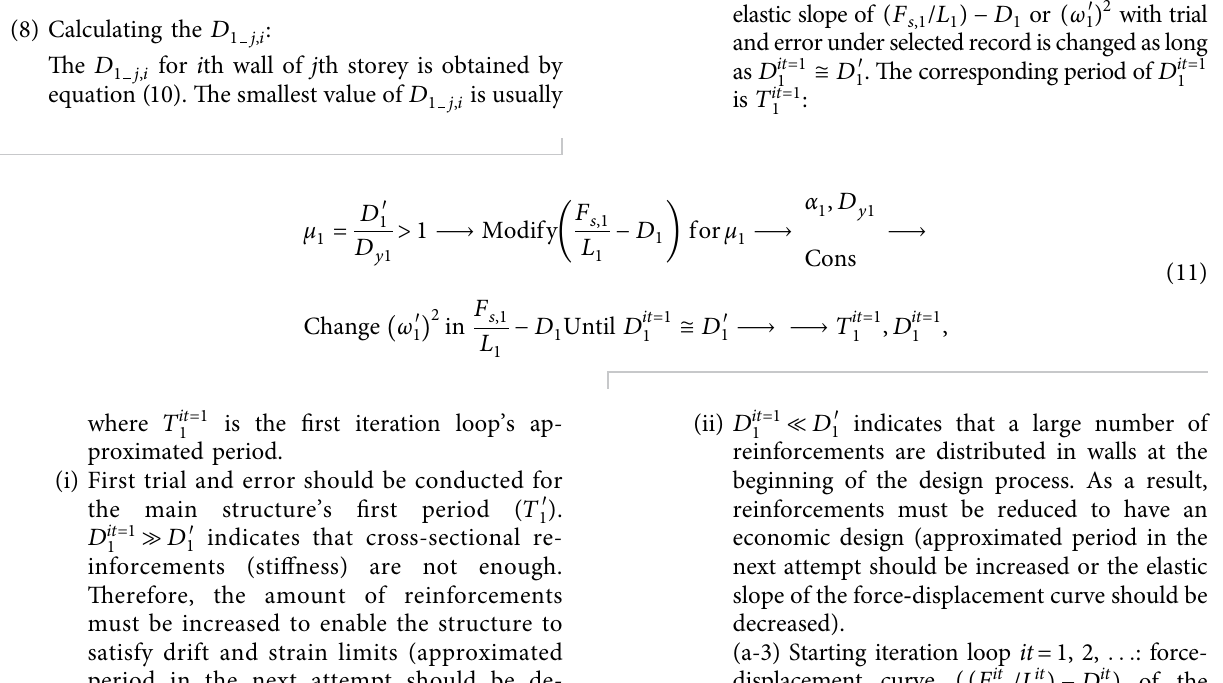
(a-2) Force-displacement